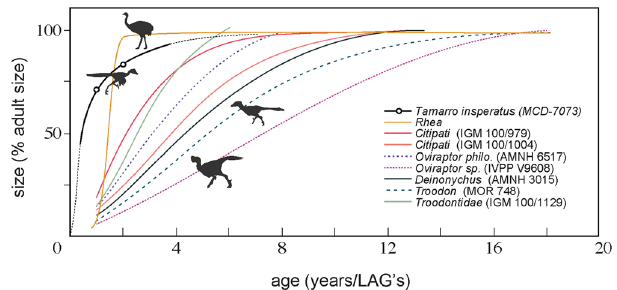
Figure 5. Growth curves of maniraptoran theropod dinosaurs. Tamarro insperatus outstands among other taxa for its fast initial growth, reaching subadulthood during the first year of